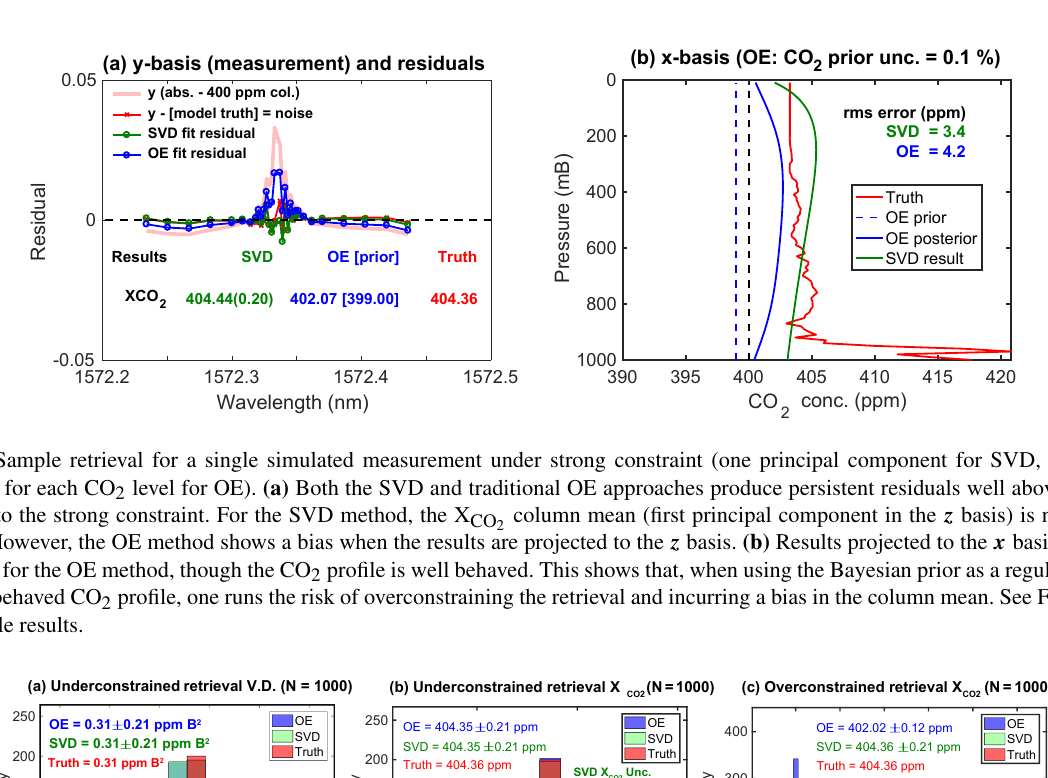
column mean (b) , which 2